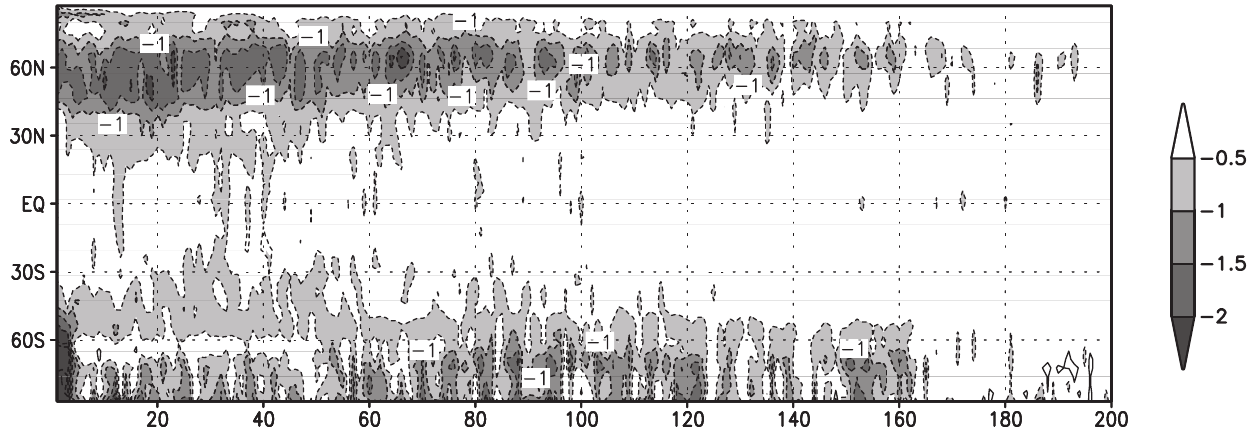
Fig. 1. Inverse trend of the SST zonally averaged obtained from the T30 experiment. The trend is computed with respect to the last 5-year mean, therefore negative values indicate a positive (warm) SST trend. Dashed contour lines and shaded areas indicate negative values. Contour interval is 0.5 °